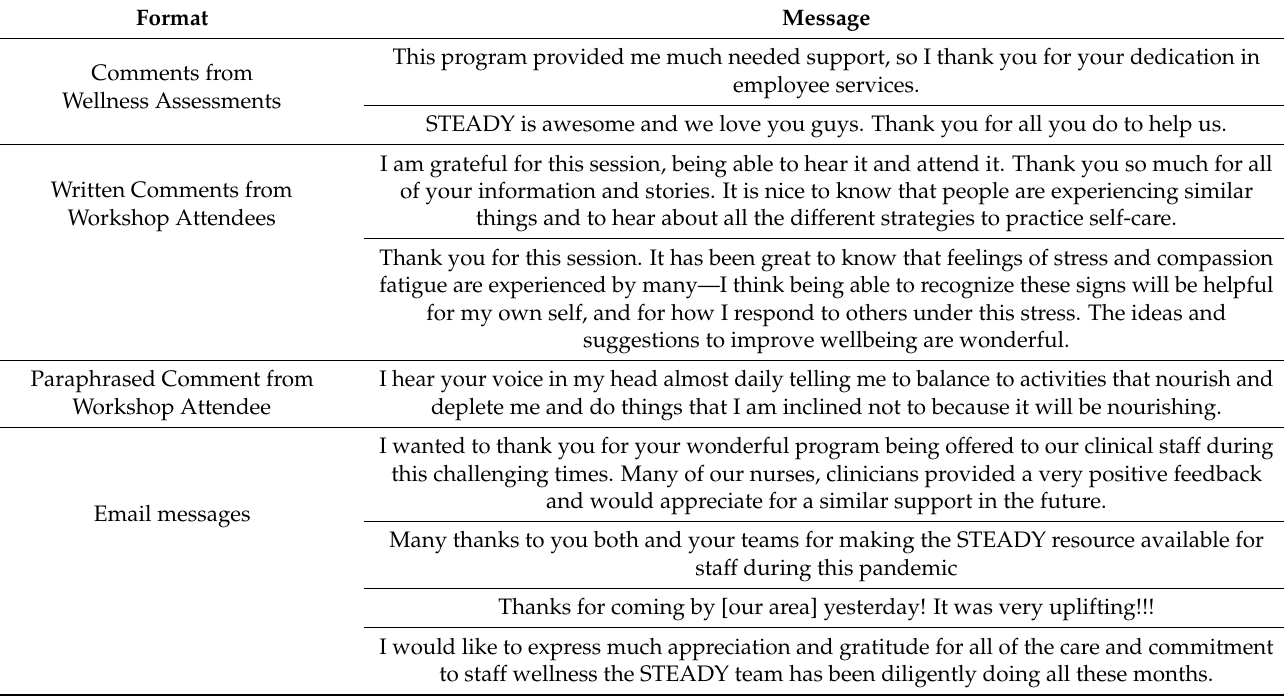
Table 4. Select messages of thanks and positive feedback received from STEADY